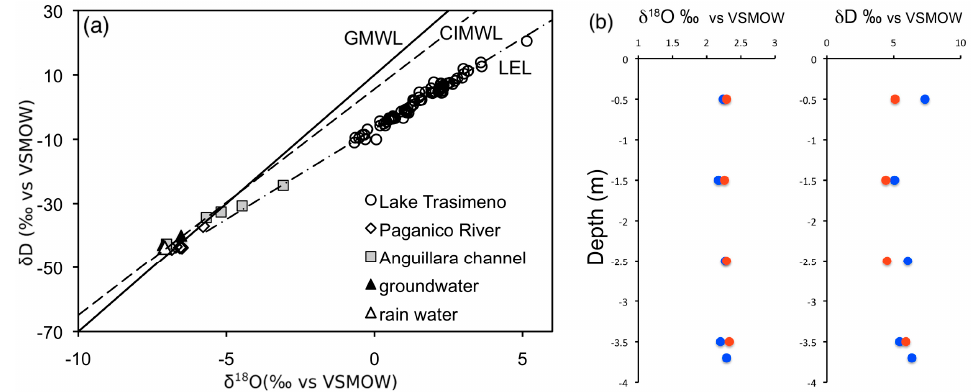
Figure 7 . ( a ) δ D vs δ 18 O diagram. Delta notation for stable hydrogen and oxygen isotopes in permil relative to Vienna Standard Mean Ocean Water (VSMOW). LEL, Local Evaporation Line; CIMWL, Central Italy Meteoric Water Line [45]; GMWL, Global Meteoric Water Line [46]. Isotopic composition of rainwater is from [45]; ( b ) variations of δ 18 O and δ D along the vertical profiles A (blue dots) and B (red dots).